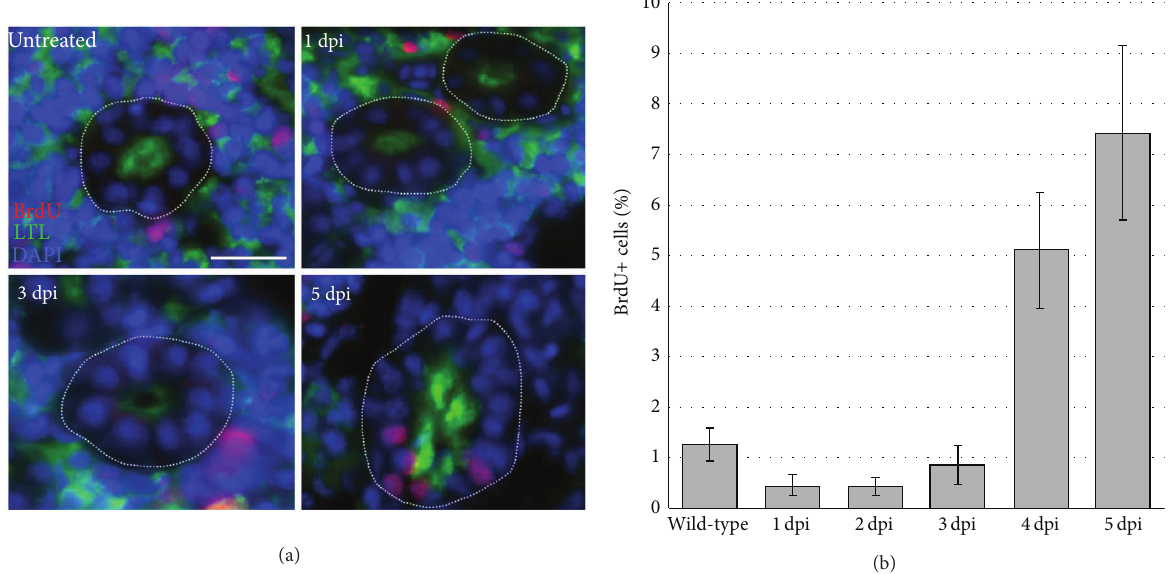
Figure 6: Regenerating proximal tubules show BrdU incorporation after gentamicin injury. (a) Kidney tissue was assayed for BrdU-positive nuclei (red), and proximal tubules were identified by LTL labeling (green). Nuclei were stained with DAPI (blue). (b) Quantification showed that BrdU incorporation occurs progressively at 3, 4, and